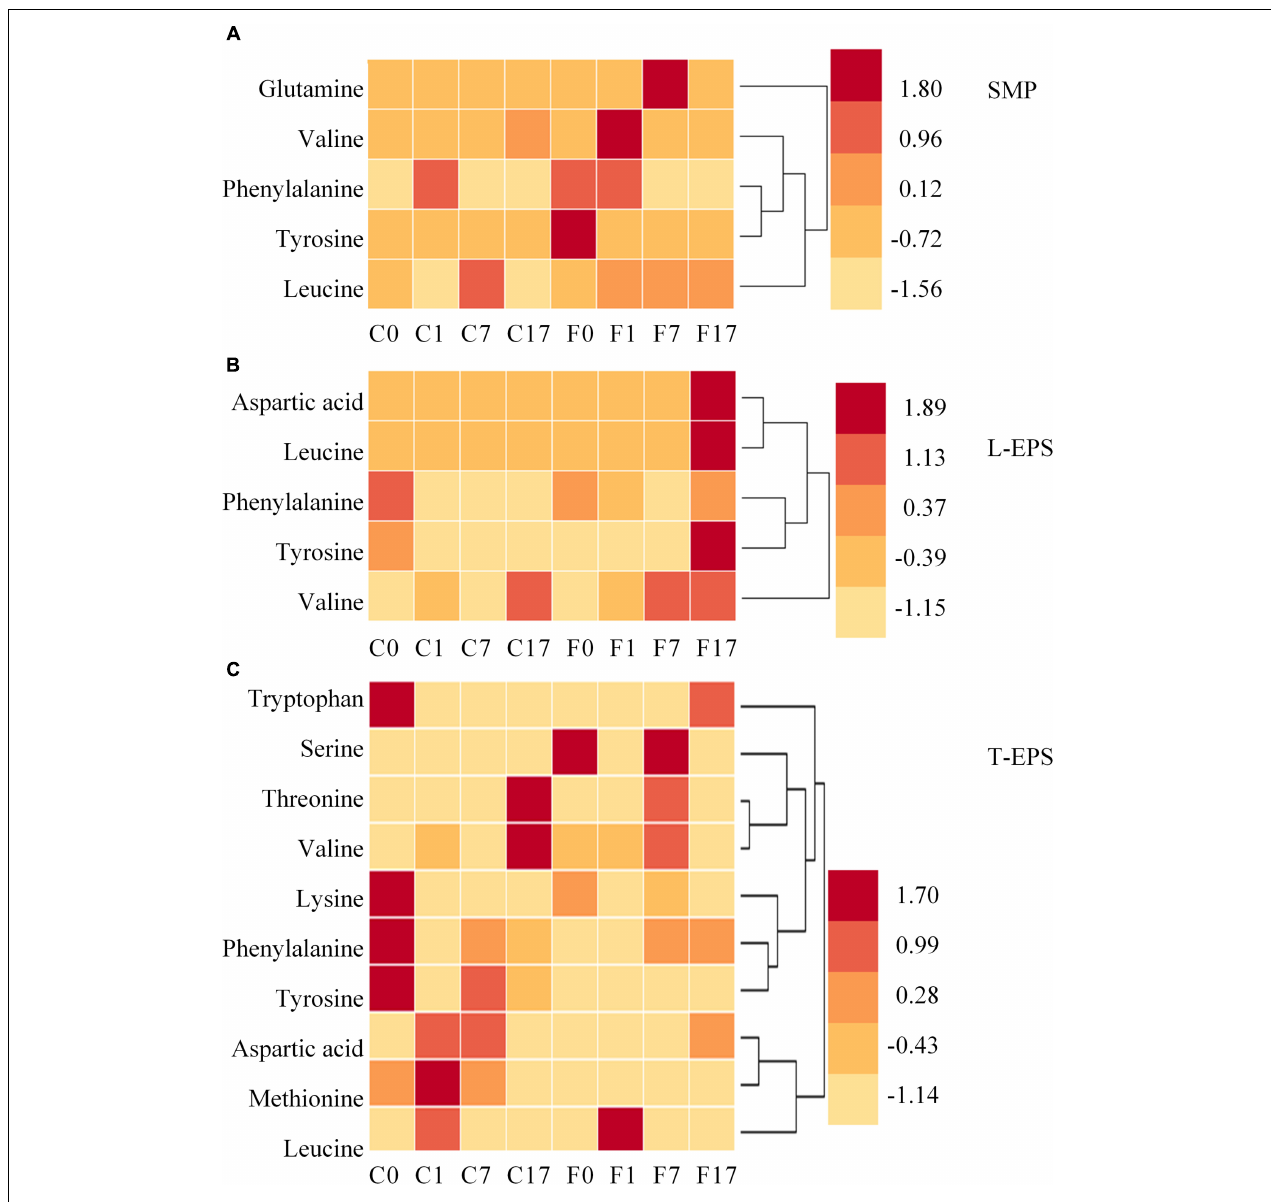
FIGURE 4 | Distribution of amino acids in panel (A) SMP phase, (B) L-EPS phase, and (C) T-EPS phase at different steps in the control and Fe 3 O 4 reactors. C0, C1, C7, and C17 refer to samples collected from the control reactor at 0, 1, 7, and 17 h. F0, F1, F7, and F17 refer to samples collected from the Fe 3 O 4 reactor at 0, 1, 7, and 17 h.